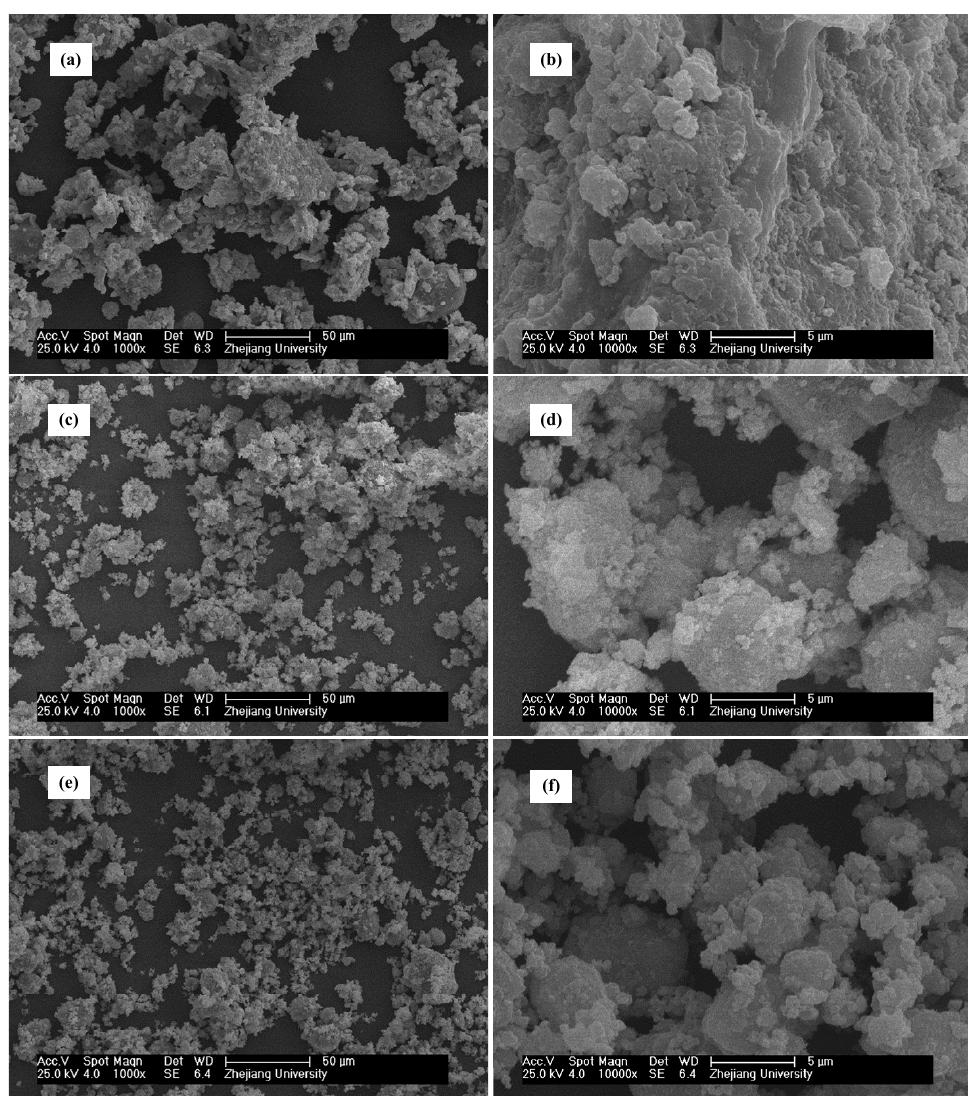
Figure 5. SEM micrographs for ( a ) raw fly ash magnified at ×1000 (1k); ( b ) raw fly ash at ×10k; ( c ) 2 h MFA at ×1k; ( d ) 2 h MFA at ×10k; ( e ) 10 h MFA at ×1k; ( f ) 10 h MFA at ×10k.